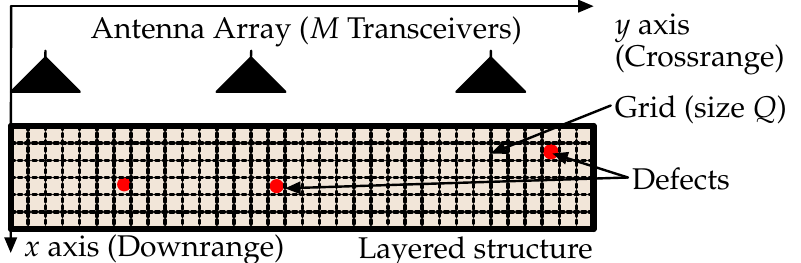
Figure 1. Getting the measurements of a single-layered material structure using an SFCW radar with M transceivers. The received signal consists of two main components, the reflection of the layered material structure ( Y l ) and the reflection of the defects ( Y d ), where Y l is the main clutter source. Here, defects are shown as red